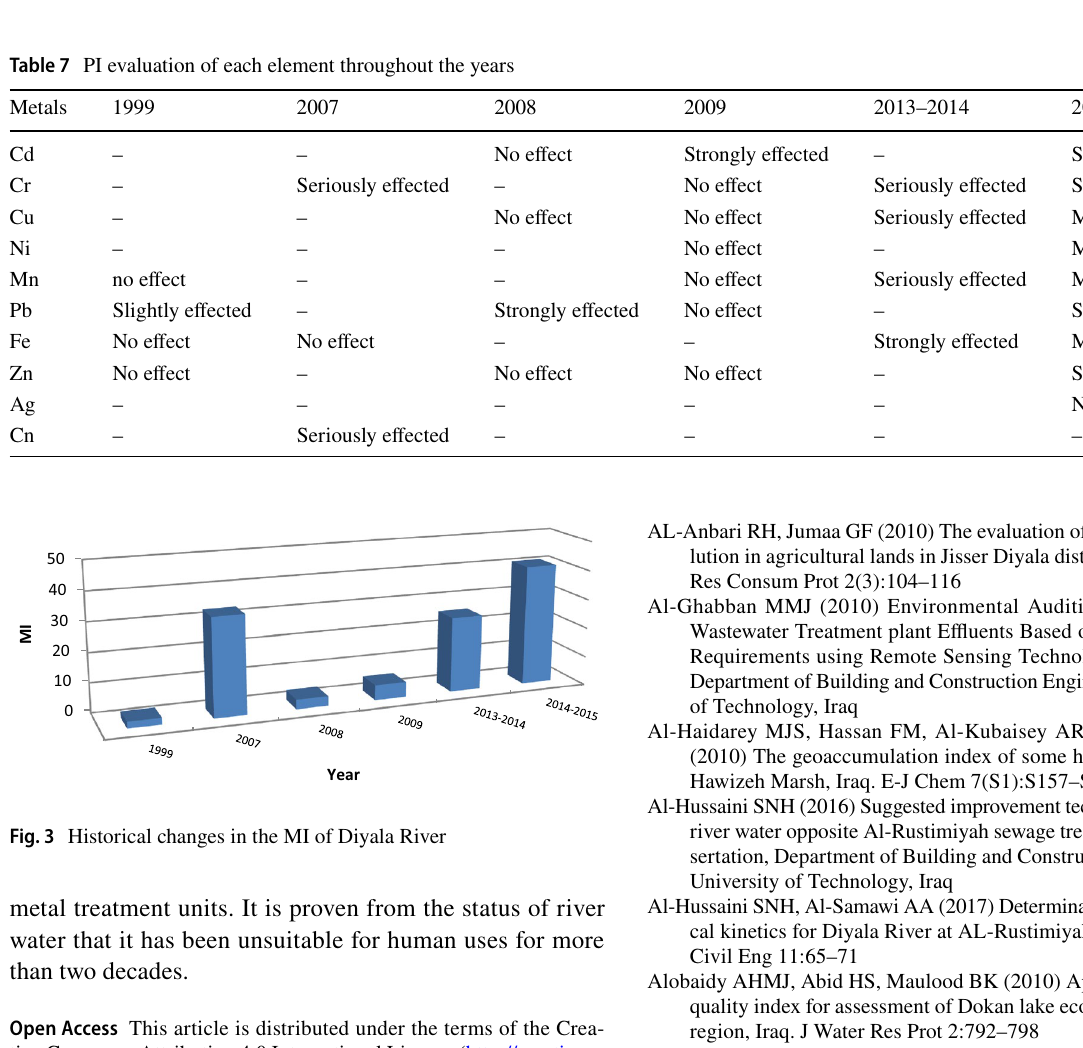
Table 6 WQI throughout the river reach for the present study